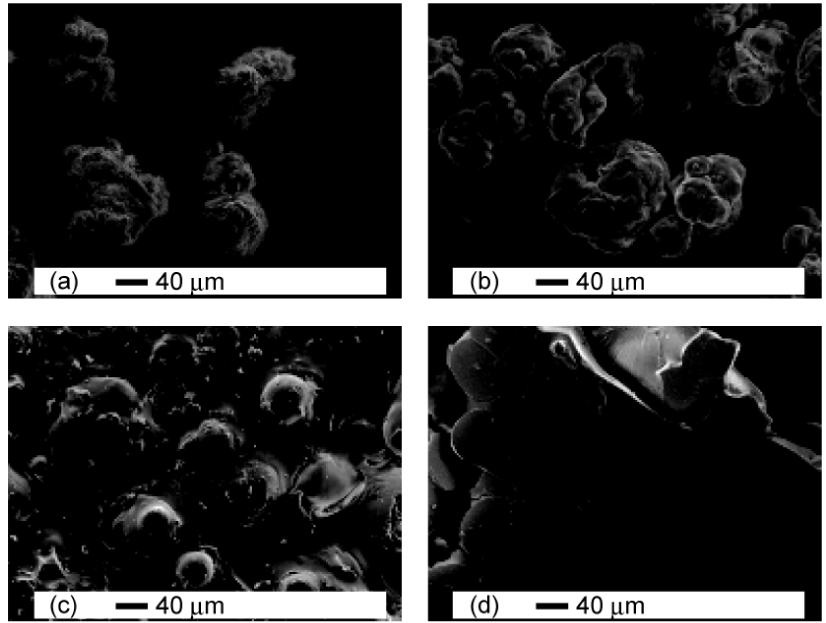
Figure 2. Surface morphology of pyrolyzed PVC-P: ( a ) unreacted PVC-P, ( b ) PVC-P pyrolyzed at 200 ◦ C, ( c ) pyrolyzed at 220 ◦ C, ( d ) pyrolyzed at 240 ◦ C, PVC/glycerol mass ratio = 2/3, reaction time = 120 min.